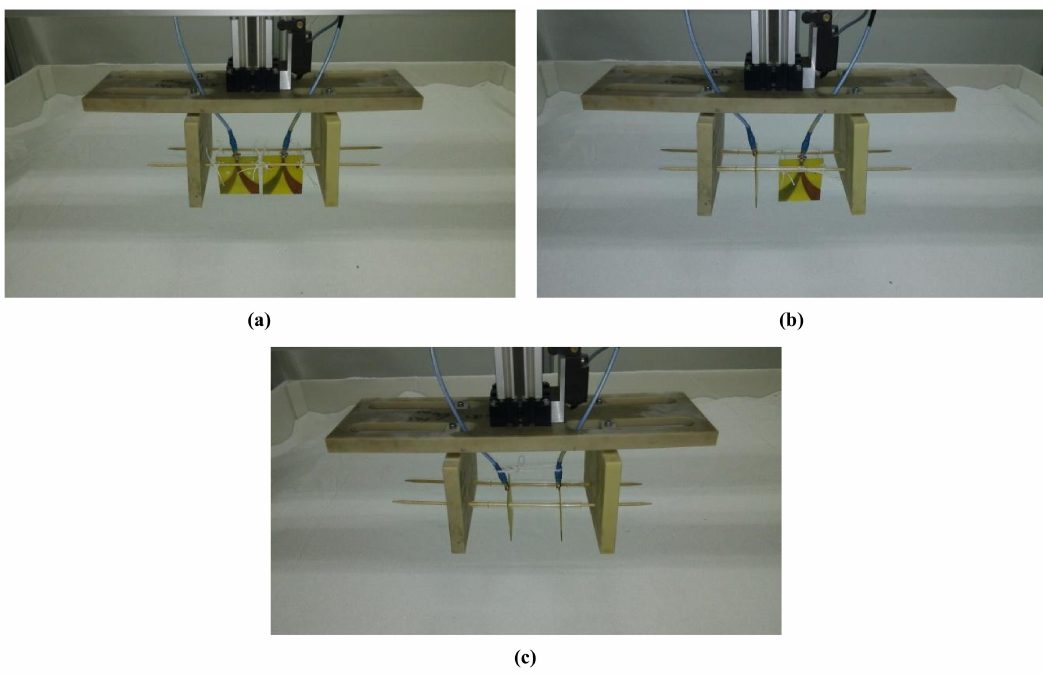
Figure 6. Three types of antenna combinations. (a) HH polarization. (b) HV polarization. (c) VV polarization. H represents horizontal polarimetric antenna, V represents vertical polarimetric antenna.